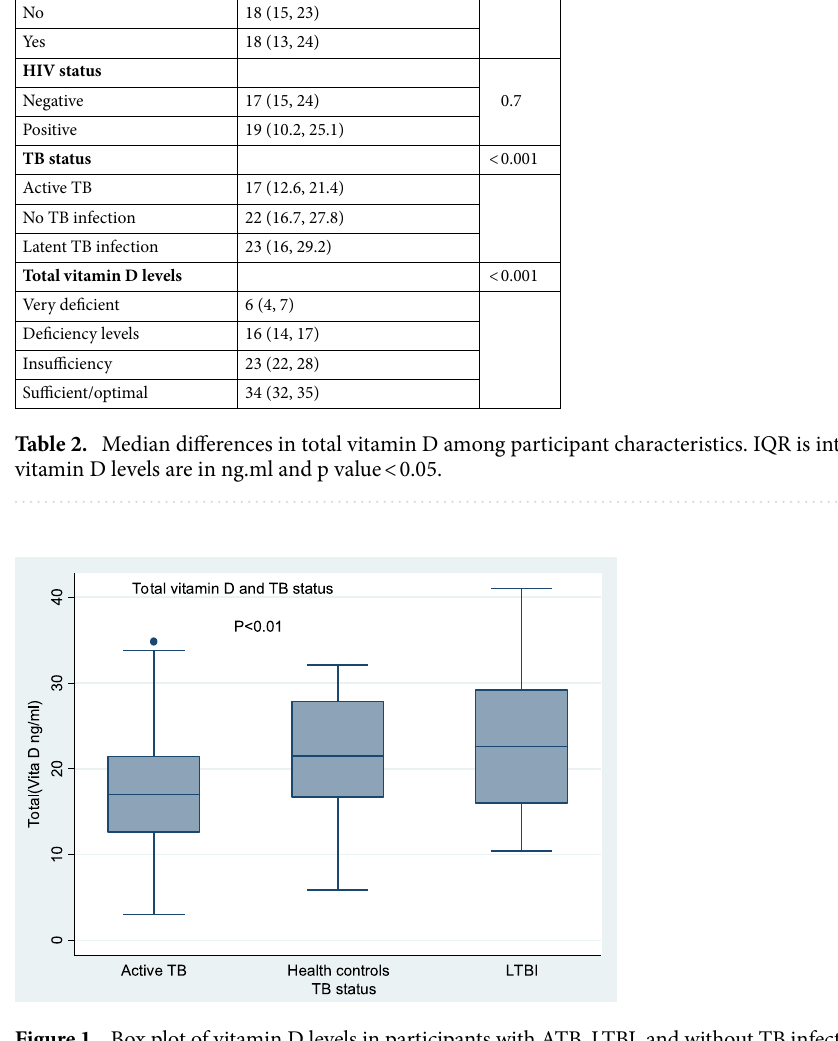
Figure 1. Box plot of vitamin D levels in participants with ATB, LTBI, and without TB infection. The boxes represent medians, and the upper and lower ends of the box represent the 75th and 25th percentiles, while the whiskers are the 5th and 95th percentiles with significance at < 0.05. Low vitamin D levels were observed in all three study groups with the lowest levels found in active TB patients (< 20 n/ml). The figure was generated using STATA version12, https:// www. stata. com by